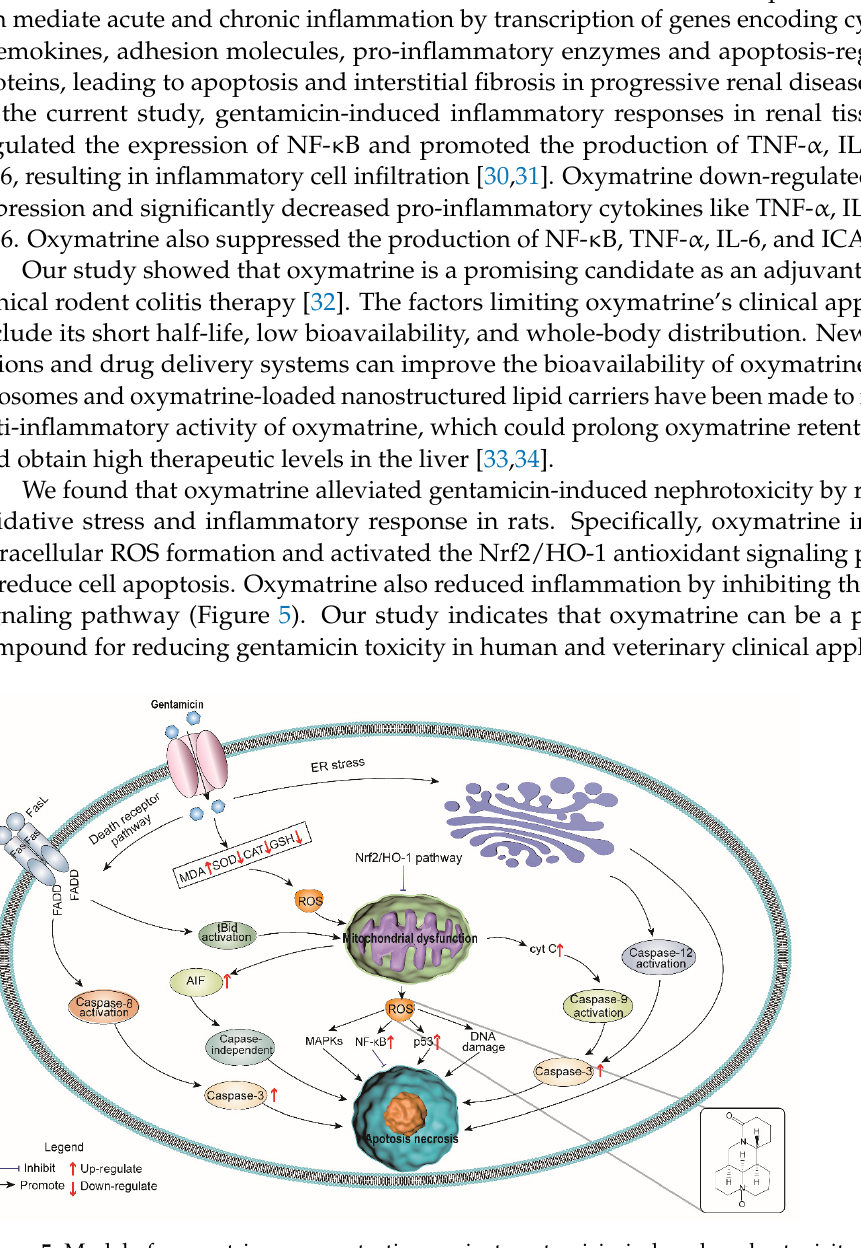
Figure 5. Model of oxymatrine renoprotection against gentamicin-induced nephrotoxicity.